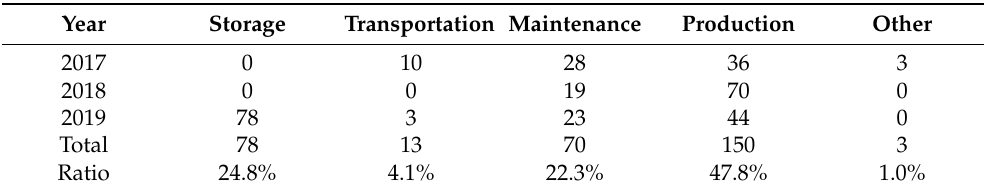
Table 2. The fatalities of the major chemical accidents in Chinese chemical industry in 2017 – 2019 [1 – 3]. Table 2.